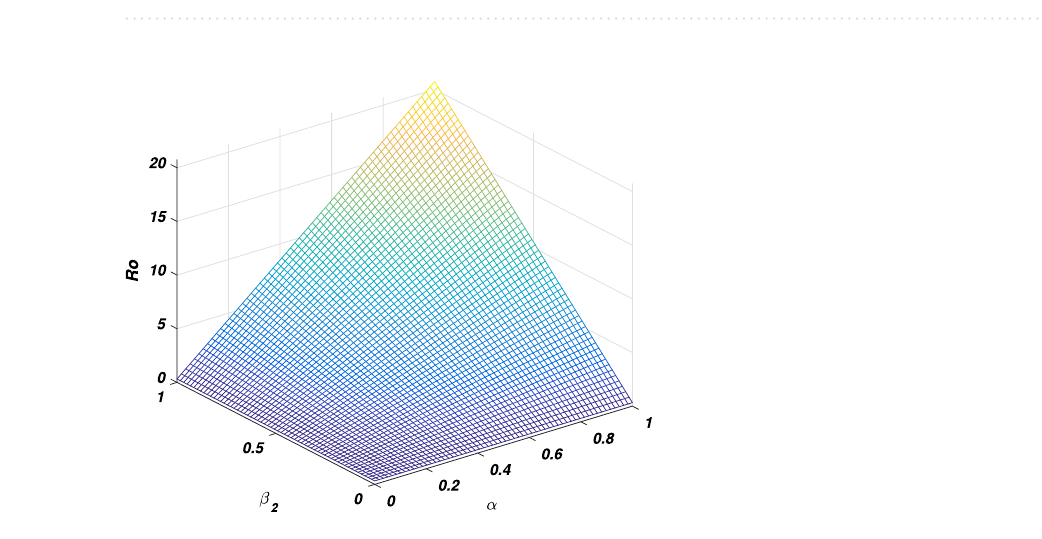
Figure 4. The graph visualizes the variation of the basic reproductive number against β 2 and α .